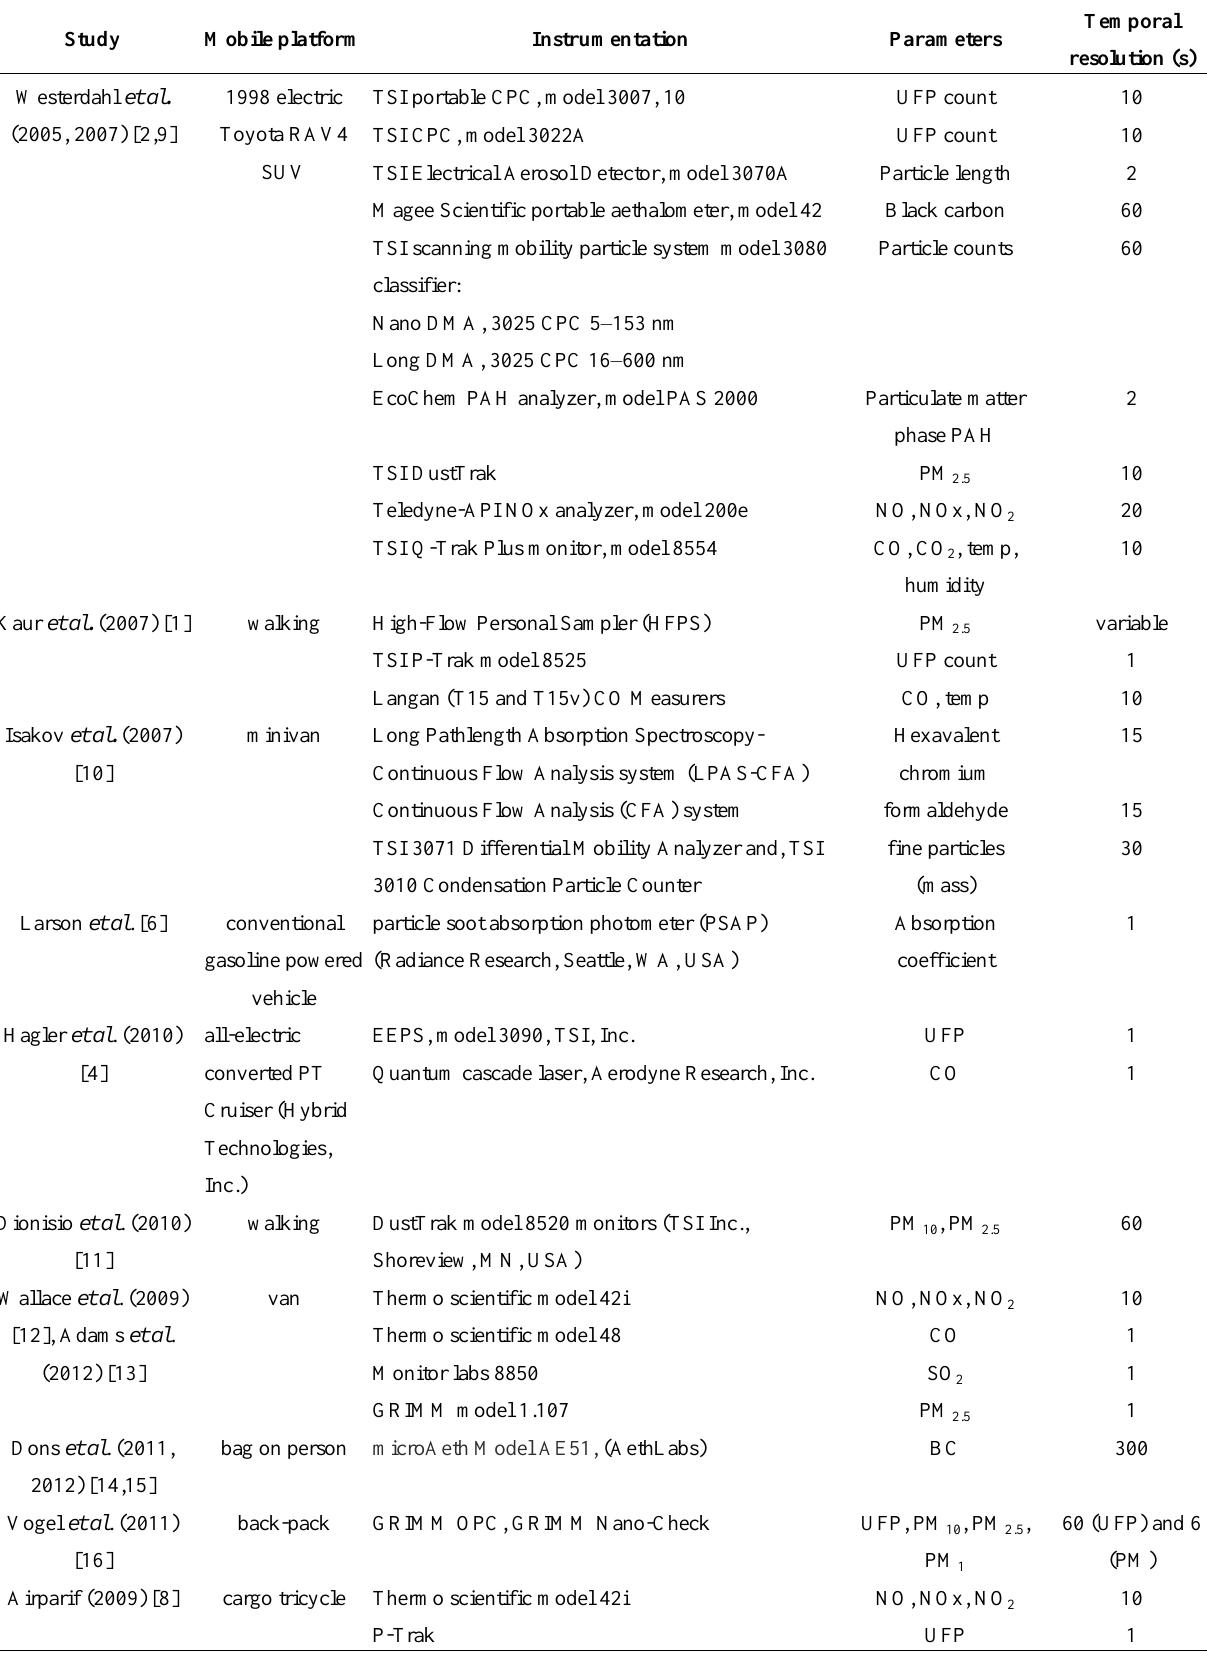
Table 1. Mobile air quality measurement